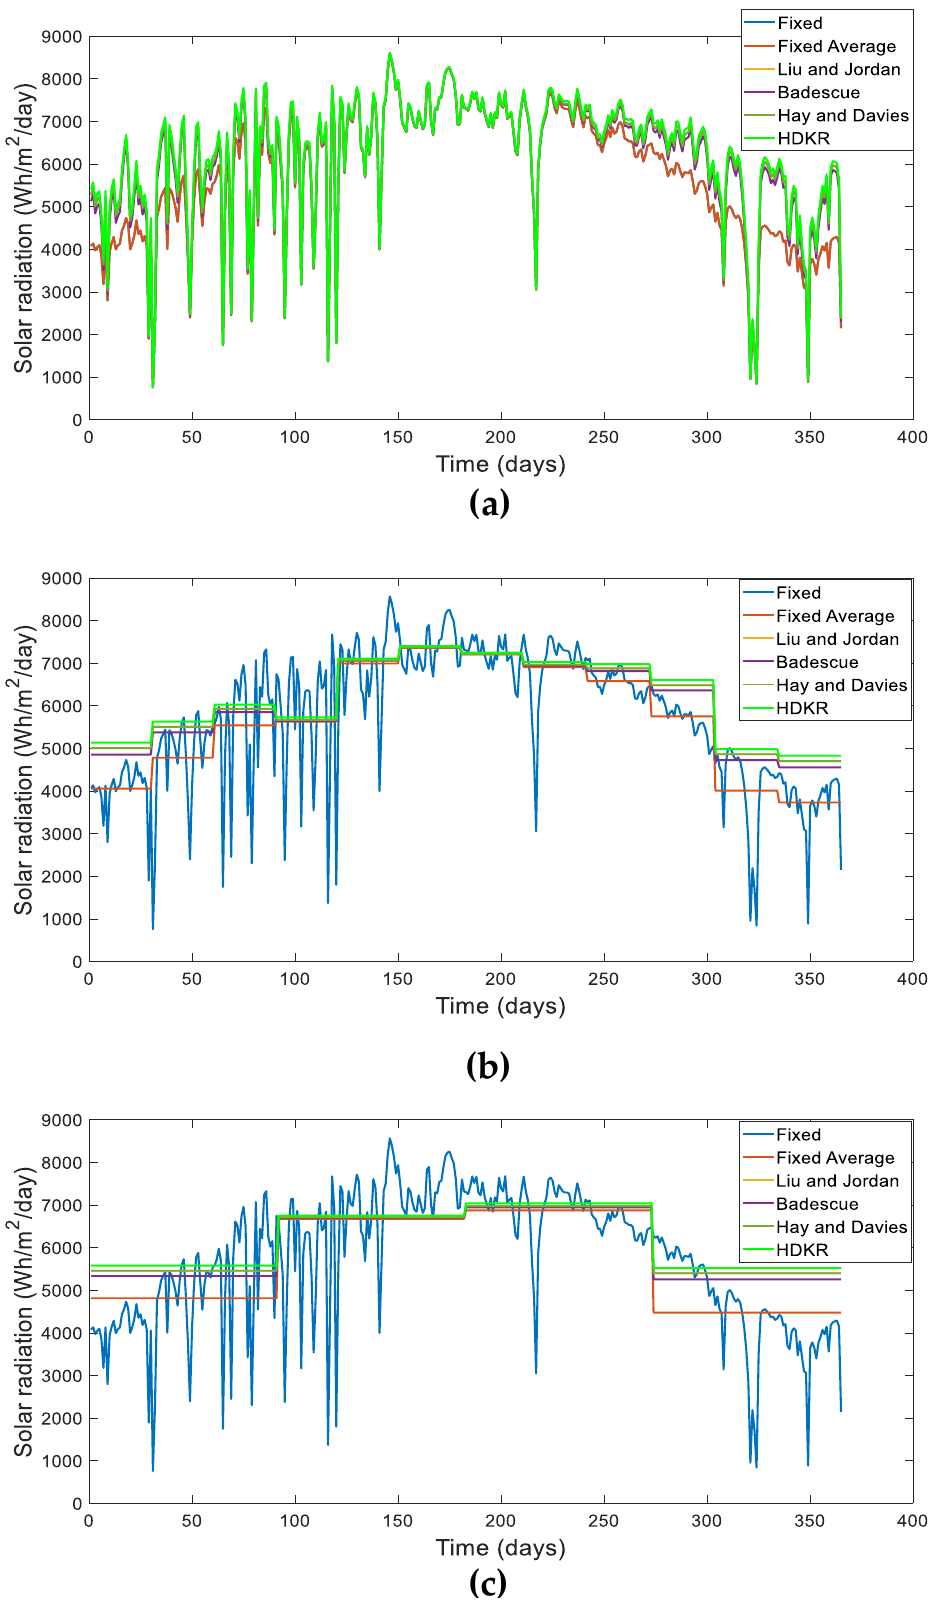
Figure 6. Comparison of the total solar radiation radiated by a horizontal versus a tilted surface for optimized tilt angle adjustment for Dhahran city over different periods: ( a ) NP = 365, ( b ) NP = 12, ( c ) NP = 4.